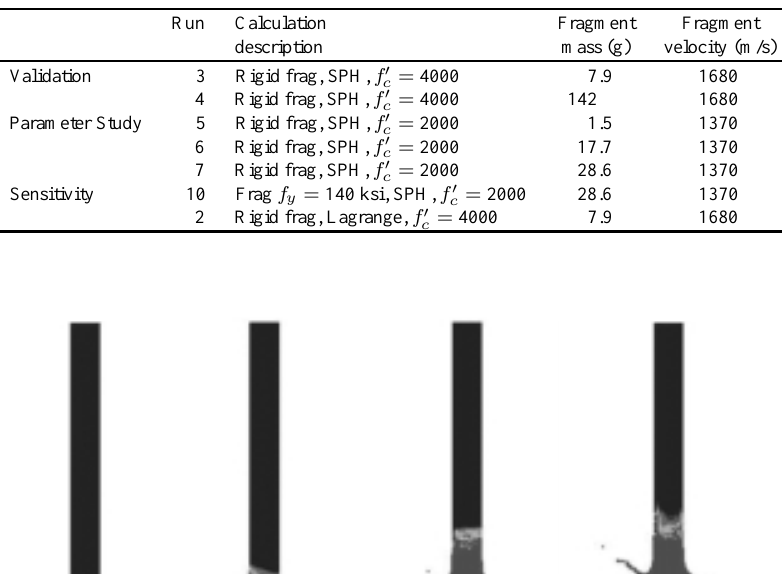
Table 1 Parameters of AUTODYN fragment impact calculations